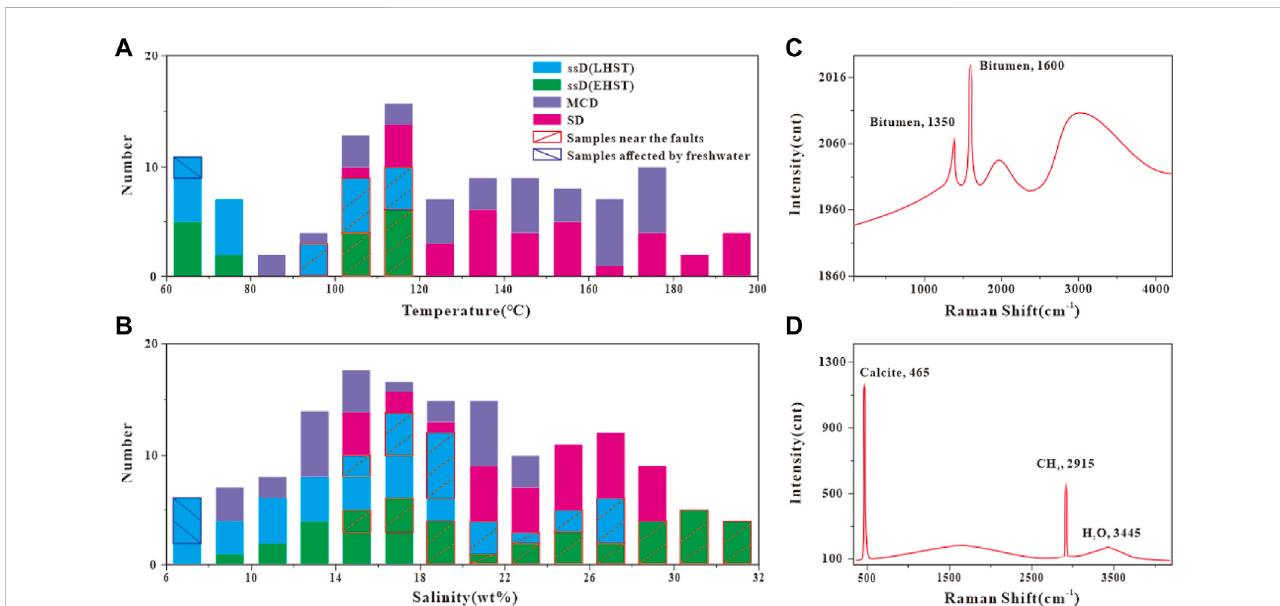
FIGURE 5 Homogenization temperature measurements and salinity determinations of inclusions in the investigated upper changping formation. (A) Homogenization temperature measurement results; (B) salinity determination results; (C) Raman spectrum characteristic of phase I hydrocarbon inclusions, mainly bitumen; (D) Raman spectrum characteristic of phase II hydrocarbon inclusions, chie fl y CH 4